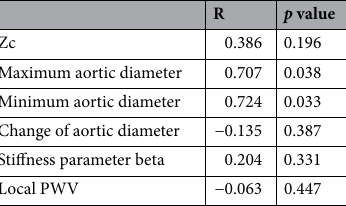
Table 3. Relationship between negative wave intensity and the parameters of aortic stiffness after EVAR using univariate analysis.